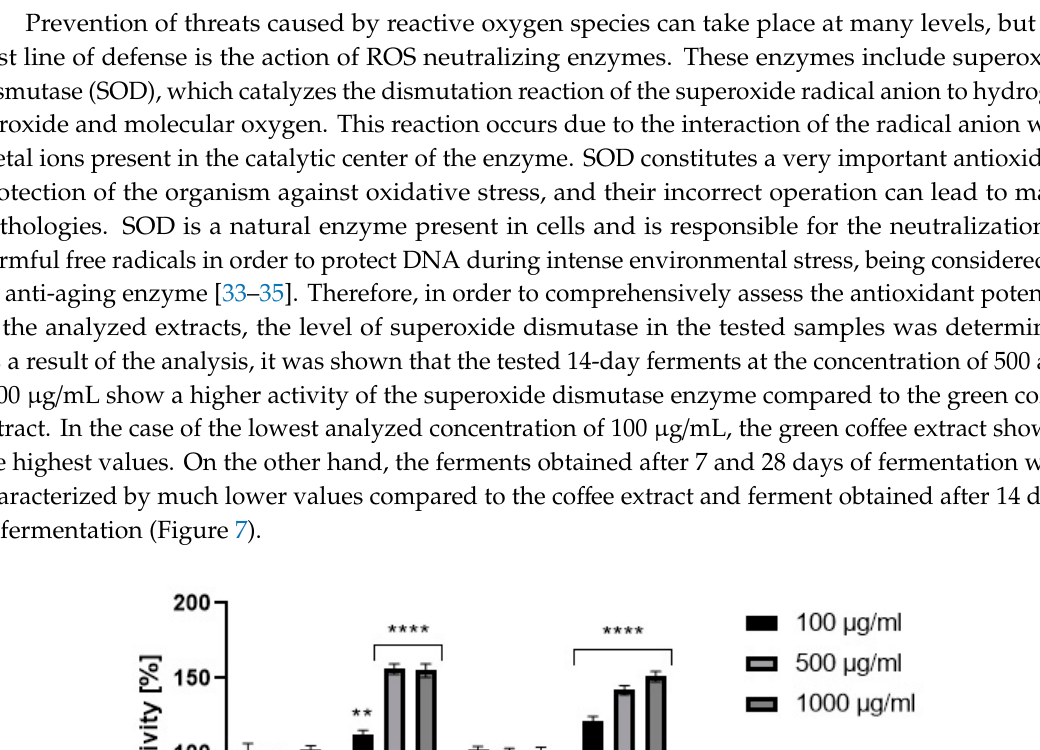
Figure 6. The effect of kombucha ferments’ extracts (F28) on the DCF fluorescence in fibroblasts and HaCaT cells. The data are expressed as the mean ± SD of 3 independent experiments, each of which consisted of 3 replicates per treatment group.